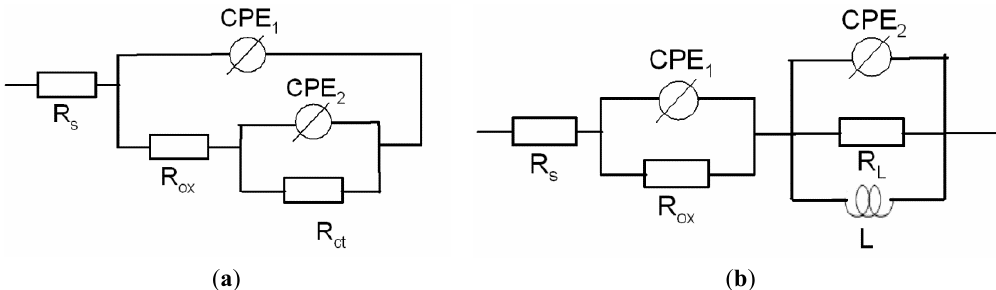
Figure 6. Equivalent circuits proposed for fitting EIS spectra obtained from ( a ) AA 1100 and ( b ) AA1100-16 vol.% B 4 C and AA1100-30 vol.% B 4 C in 3.5% NaCl solution.